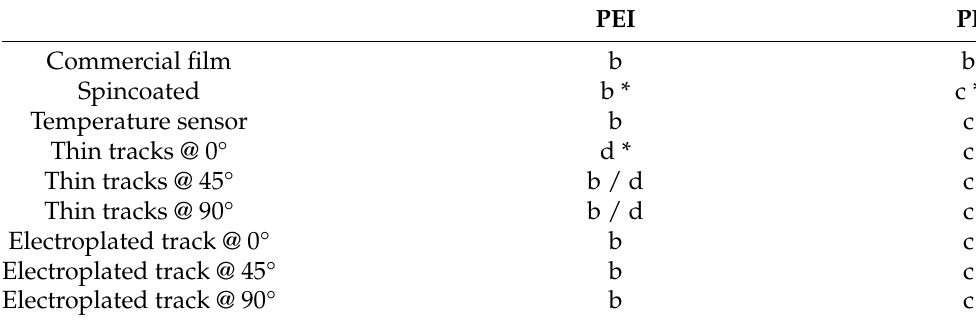
Table 1. Damaging modes compared to the modes shown in Figure 6. The “*” symbol indicates the specimen groups, that belong to the diagrams shown in Figure